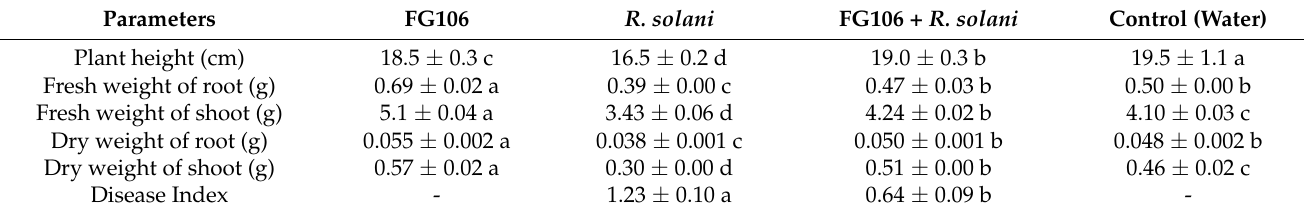
Table 3. Effects of P. aeruginosa strain FG106 on disease index and growth parameters of tomato plants under control and biotic stress caused by R. solani exposure.